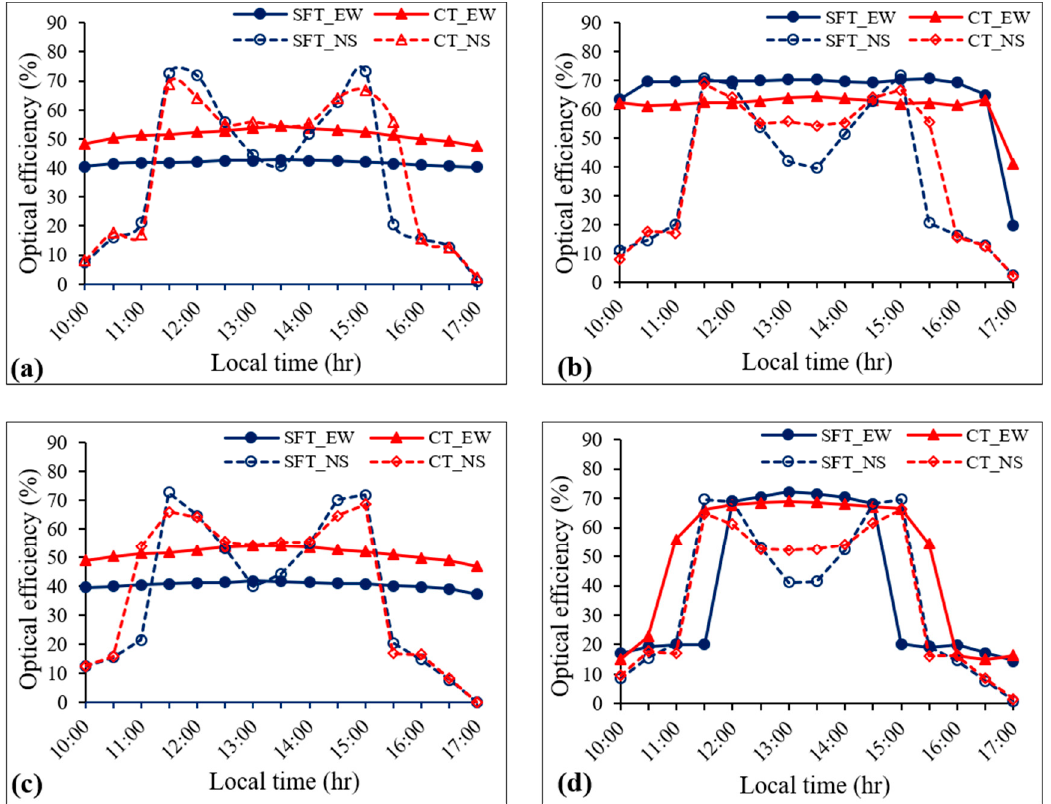
Figure 12. The optical efficiency of 60% truncated CPC collector integrated with SFT and CT receiver at: ( a ) spring equinox; ( b ) summer solstice; ( c ) autumn equinox; ( d ) winter solstice.